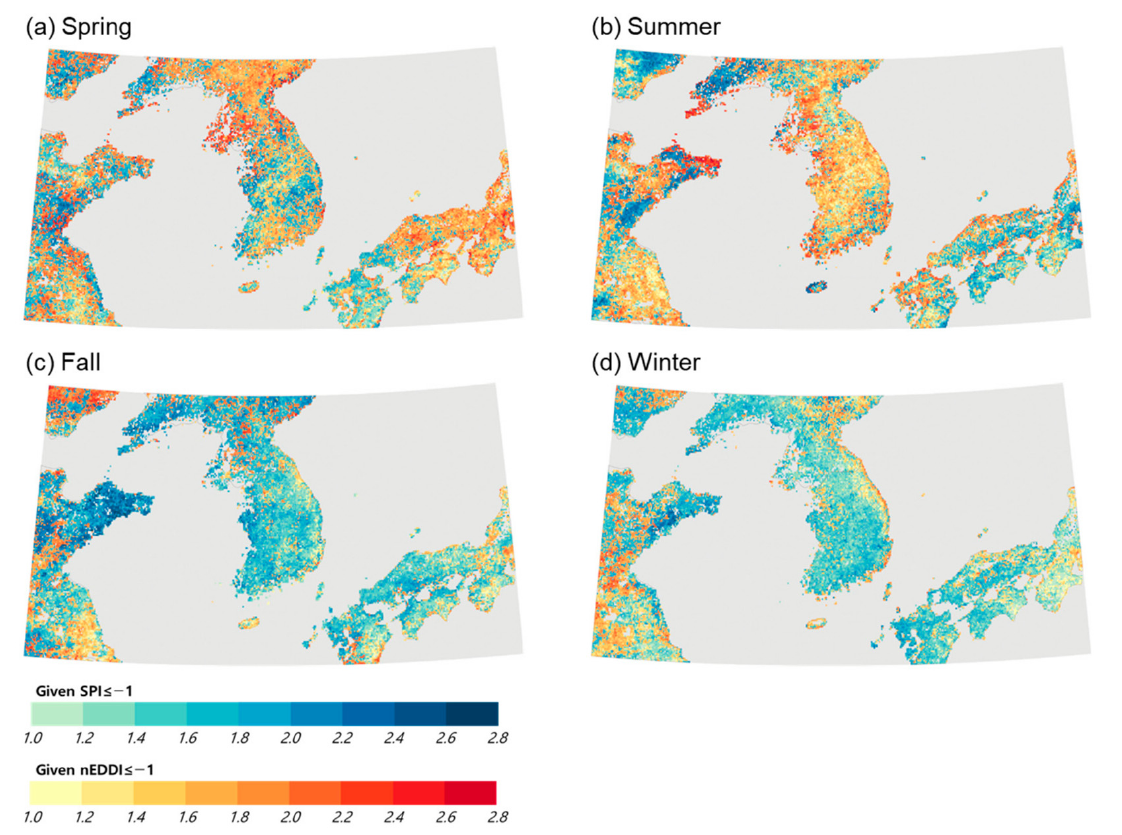
Figure 11. Sensitivity of vegetation drought to extreme meteorological